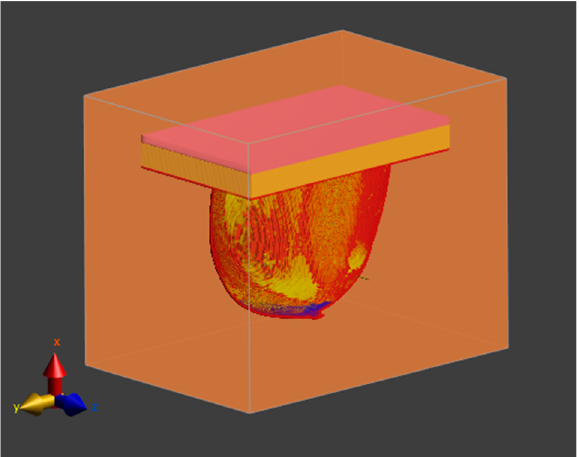
Figure 3. Computational area surrounding the female breast model.